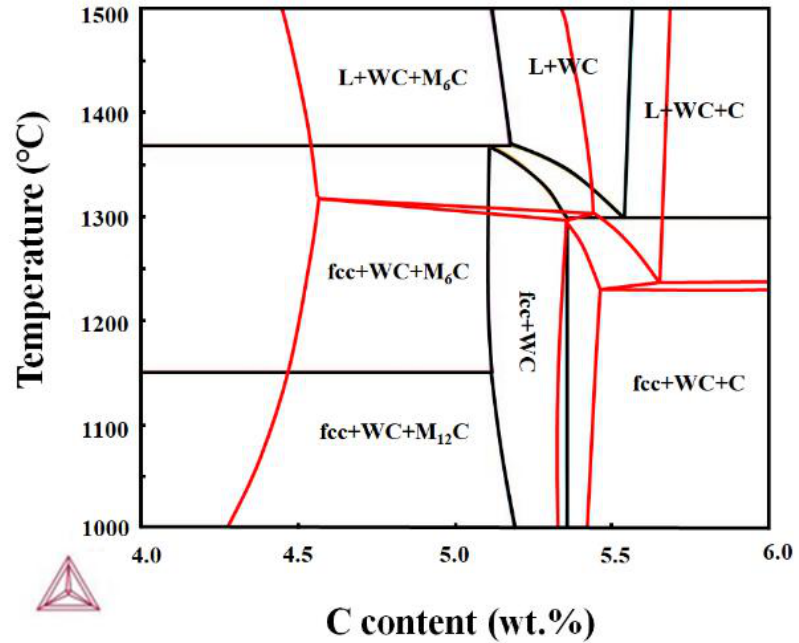
Figure 3. Isopleth calculated with ThermoCalc software using TCFE10 database corresponding to the WC–13Co (Black) and WC–9Co–4Fe (Red) composites. The eta phase can be clearly observed in the BSE-SEM images in Figure 4. With the addition of Fe from 0 to 4.0%, the area fraction and the size of the eta phase increase sharply. In the 0Fe-5.3C sample, the eta phase size is relatively small, and most eta phases are slightly larger than WC grains and, moreover, in the samples adding 4% Fe, the size of some eta phases reache ~10 µ m, which is more than five times the WC size. With the increase of carbon black in the sample adding of 2% Fe, the fraction of the eta phase gradually decreases and it finally disappears in the sample of